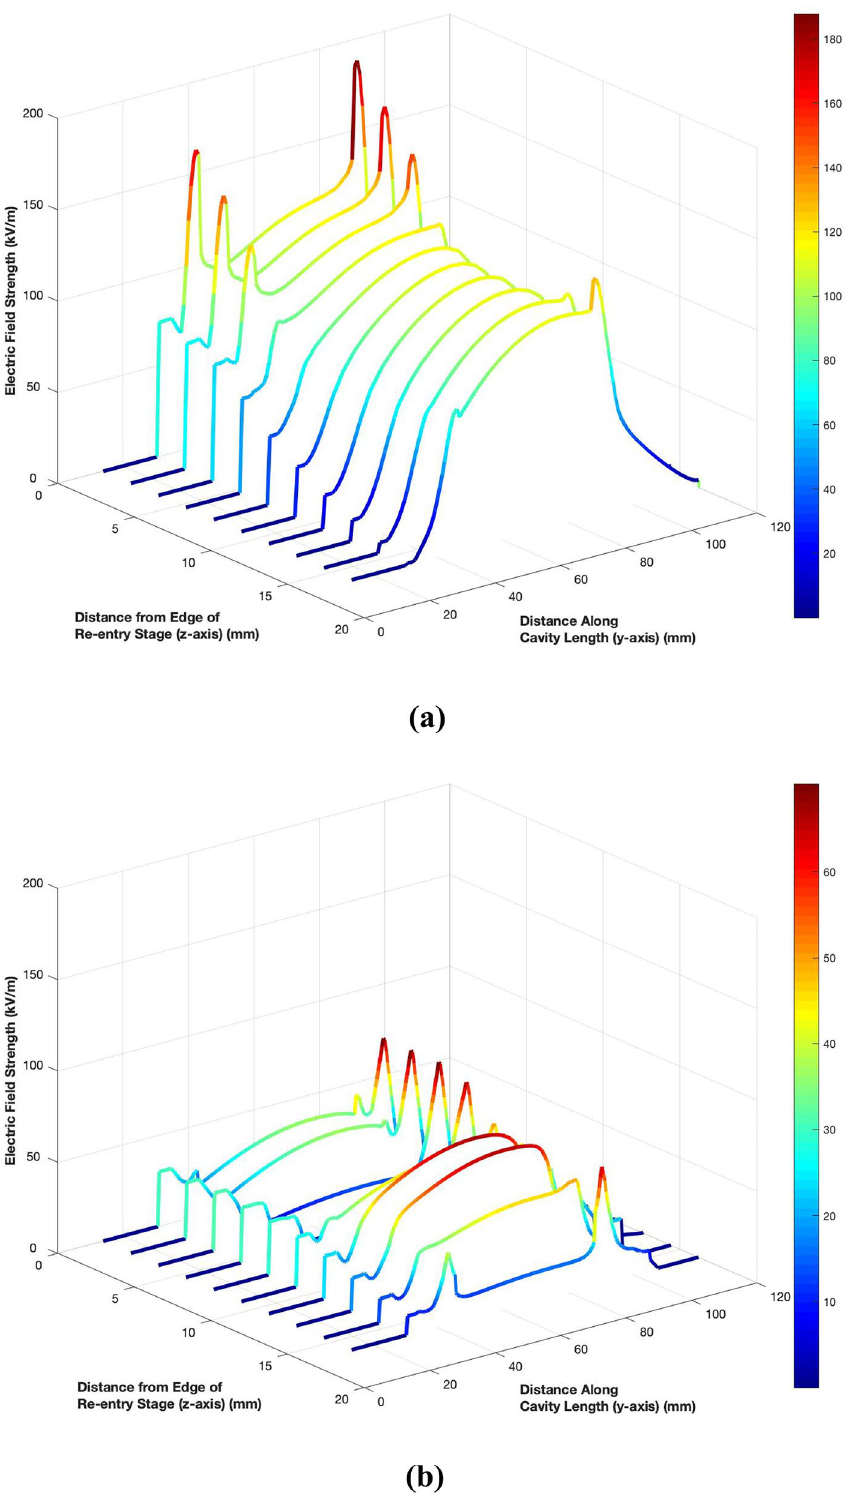
Figure 7. Electric field distribution for optimised cylindrical re-entrant resonant cavity exposure system with a semi-circular metallic ring; ( a ) Unloaded cavity; ( b ) Cavity loaded with 12 ml of cell